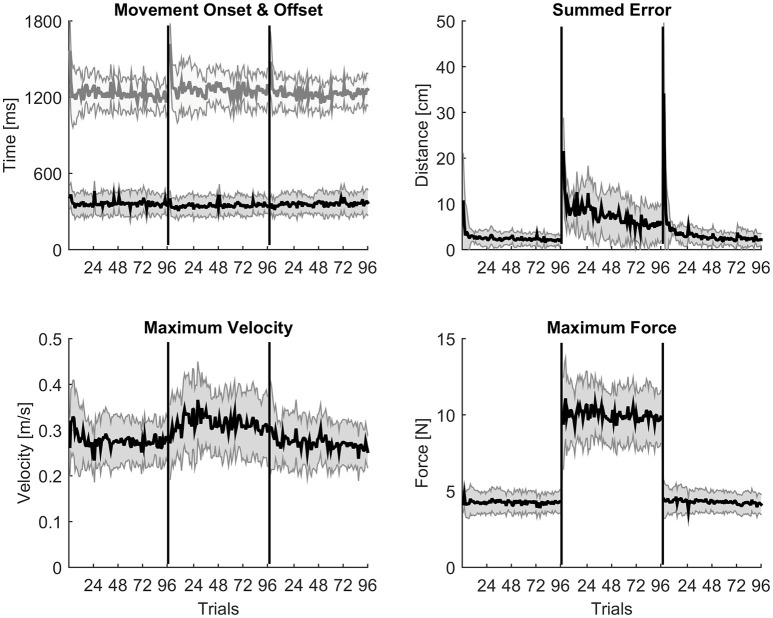
Trial-by-trial kinematic evidences of motor adaptation. A trial-by-trial population average (N = 16) profile with shaded standard deviation for each kinematic measure across the three experimental conditions. Movement onset and offset are almost constant throughout the whole experimental protocol; peak velocity and peak force show a typical constant increase of values during the adaptation condition; summed error instead slowly decreases trial by trial during adaptation as expected.